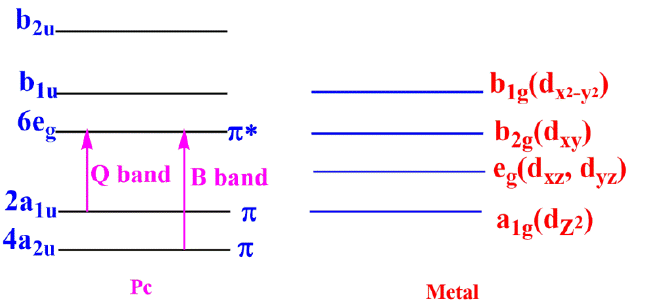
Figure 3. The diagram of molecular orbital of MPc.